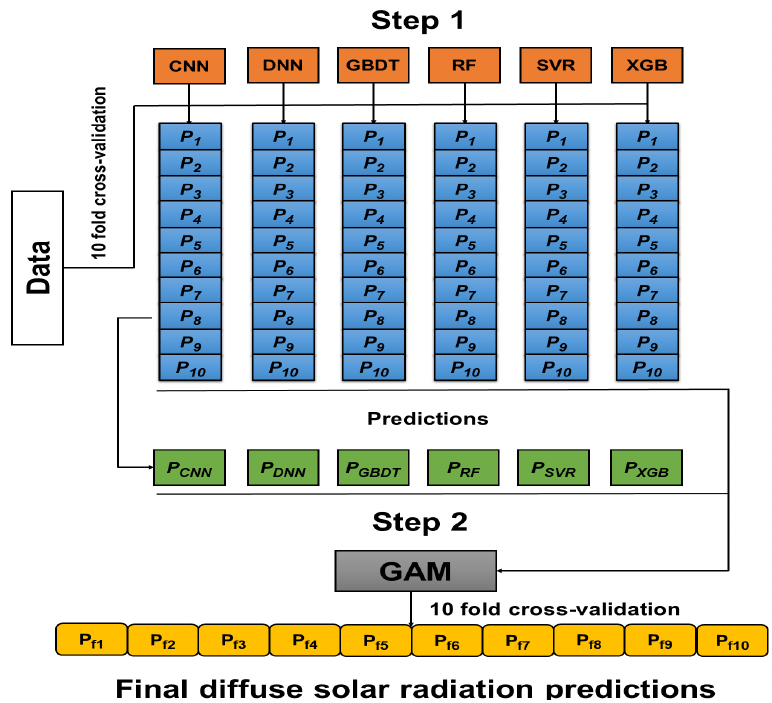
Figure 2. Flowchart of ensemble model construction process.